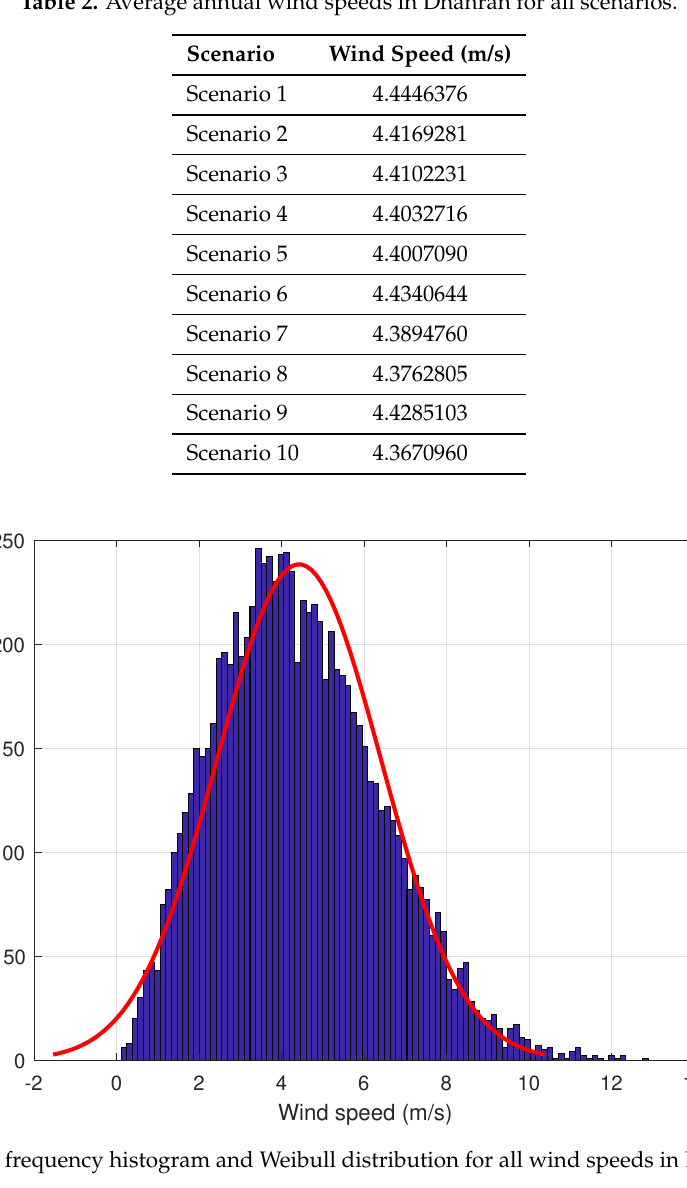
Table 2. Average annual wind speeds in Dhahran for all scenarios.